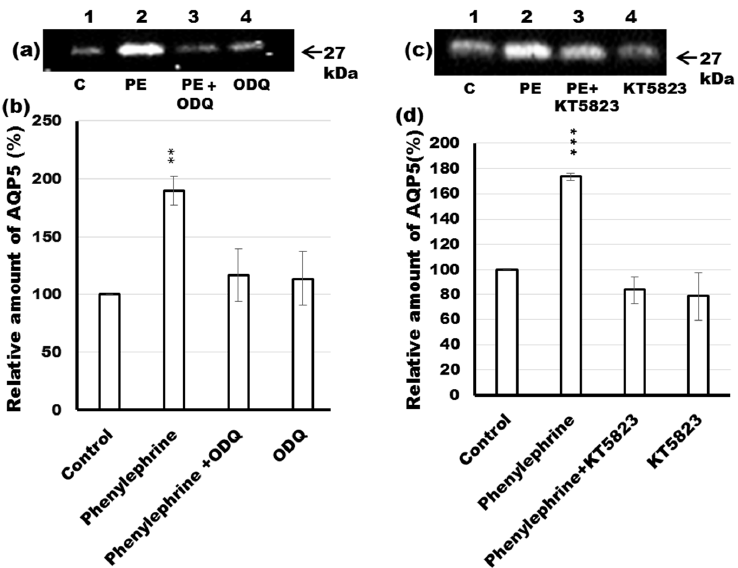
Figure 5. Effects of the antagonists ODQ and KT5823 on phenylephrine-induced increases in AQP5 levels in the APM. ( a ) Tissue slices from rat parotid glands were incubated for 10 min at 37 °C in the absence (lanes 1 and 4) or presence of 1 µM phenylephrine (lanes 2 and 3) plus 10 µM ODQ (lanes